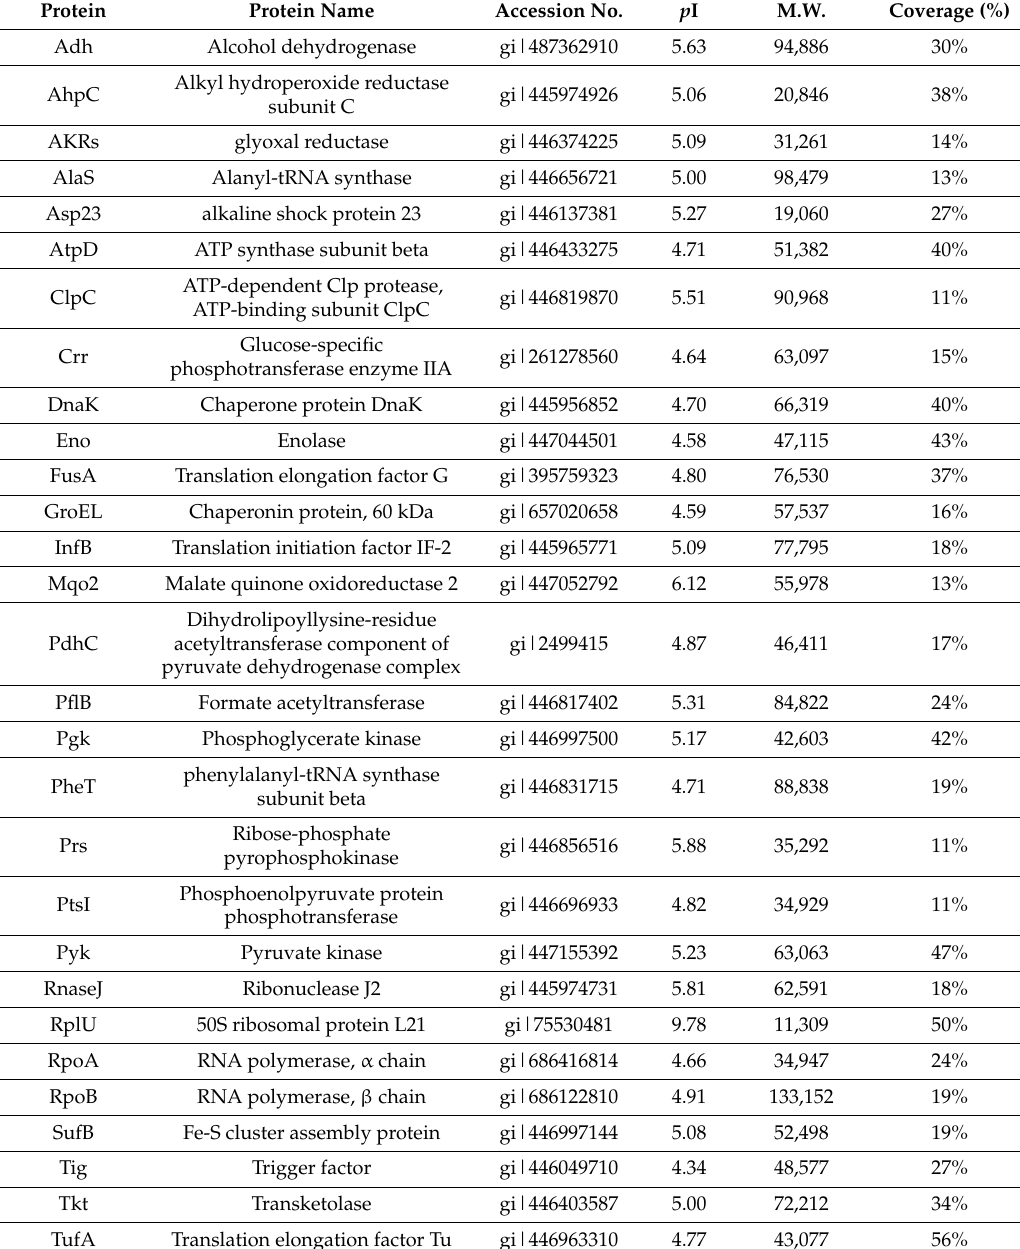
Table 2. Proteins of MRSA identified by LC-MS/MS fingerprints in treatment of ursolic acid.